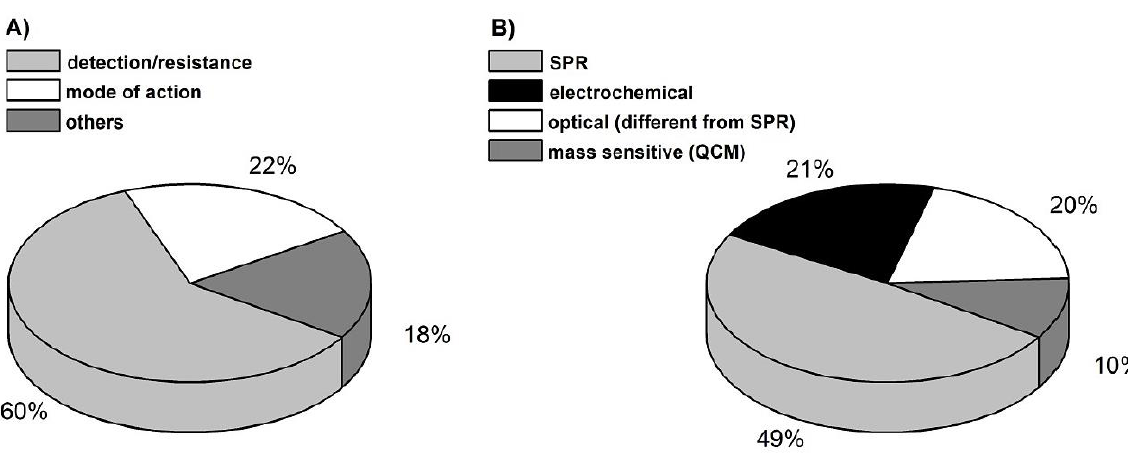
Figure 10. Distribution of detection techniques for antibiotic residues in the food industry (Reproduced with permission from K. Reder-Christ and G. Bendas [19]).